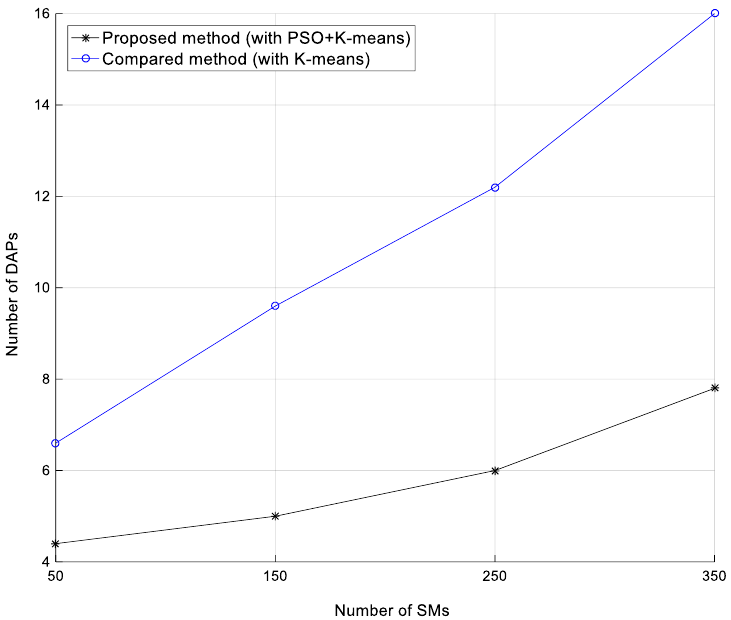
Figure 8. The comparison of the required number of DAPs with different numbers of SMs ( 𝑑 𝑠𝑛𝑟 = 7.1 km ).